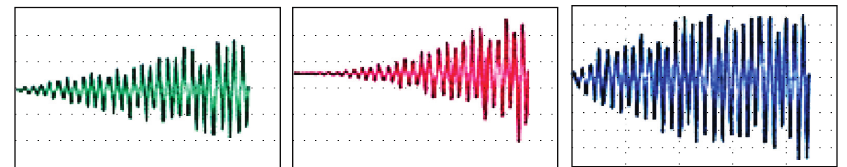
Figure 3: Different forms of demand increase in acceleration